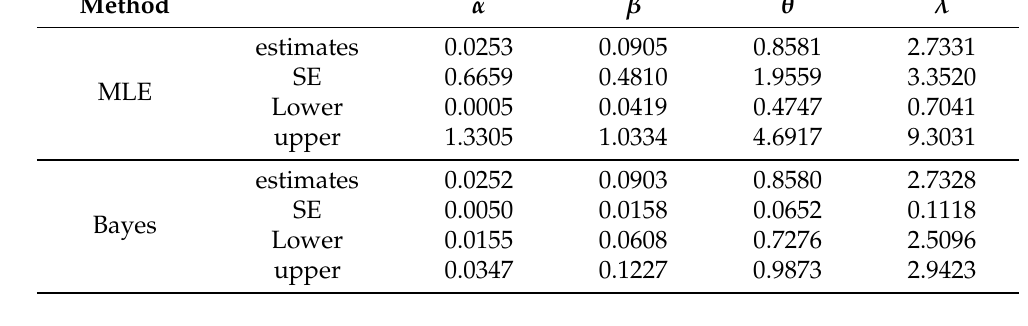
Table 17. MLE and Bayesian estimation methods of the TLMW model parameters for waiting times.